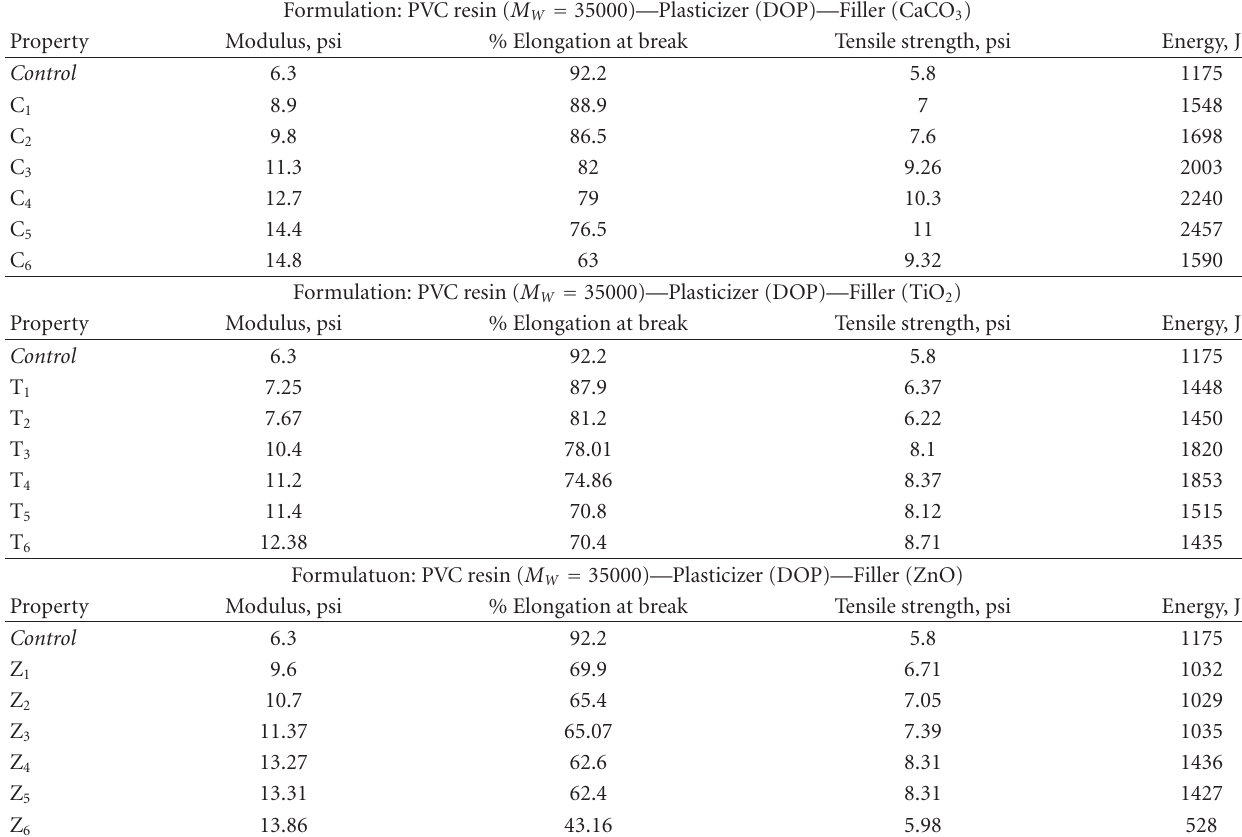
Table 2: Mechanical properties of prepared